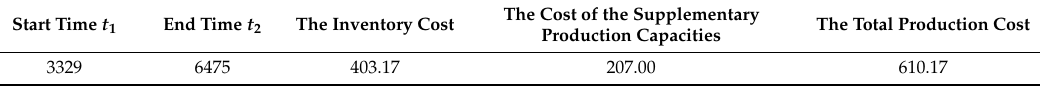
Table 8. The supplementary time of the production capacities and the